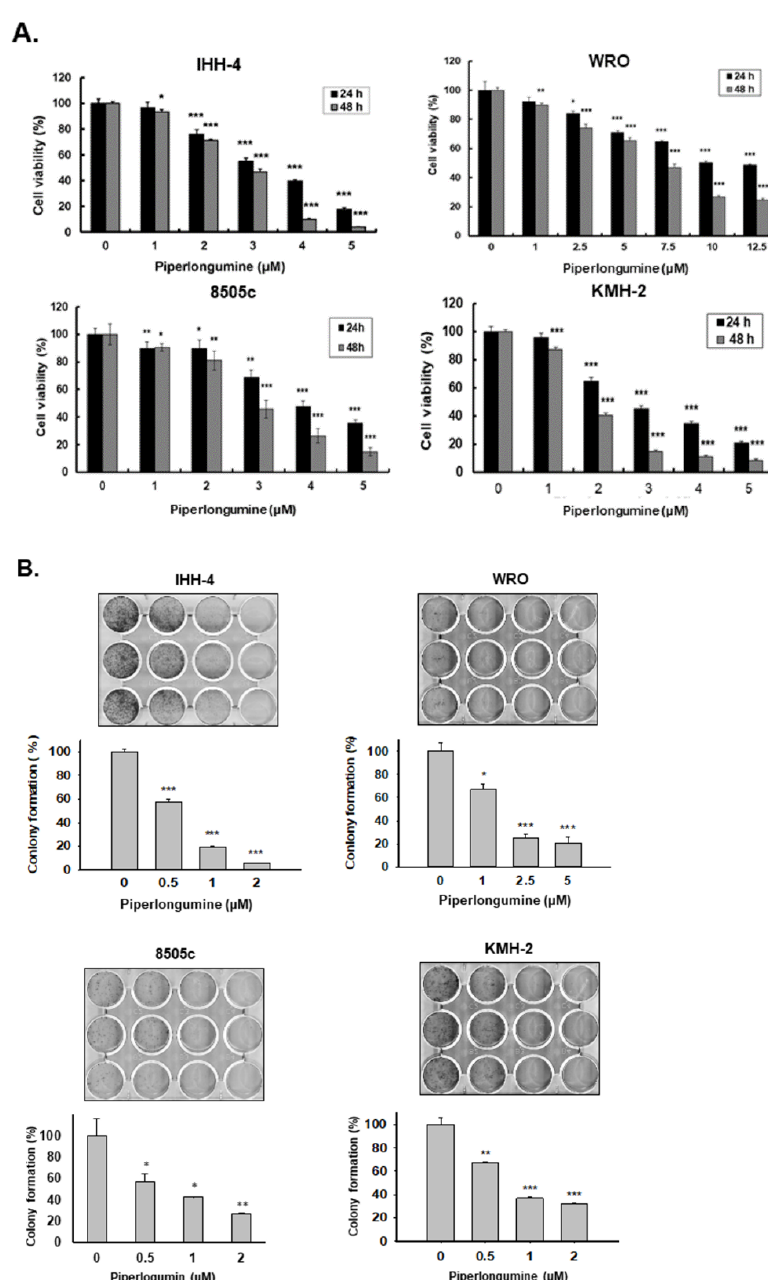
Figure 1. Suppression of tumor growth and colony formation by piperlongumine (PL) in vitro in human thyroid cancer cells. Three types of human thyroid cancer cells, namely, papillary thyroid cancer (PTC) (IHH-4), follicular thyroid cancer (FTC) (WRO), and anaplastic thyroid cancer (ATC) (8505c and KMH-2), were incubated with PL, and the ( A ) cellular viability and ( B ) colony formation were examined. Dimethyl sulfoxide (DMSO) was used as a negative control. Three independent experiments of cellular viability were conducted. Compared with the control group, * indicates p < 0.05, ** indicates p < 0.01, *** indicates p <